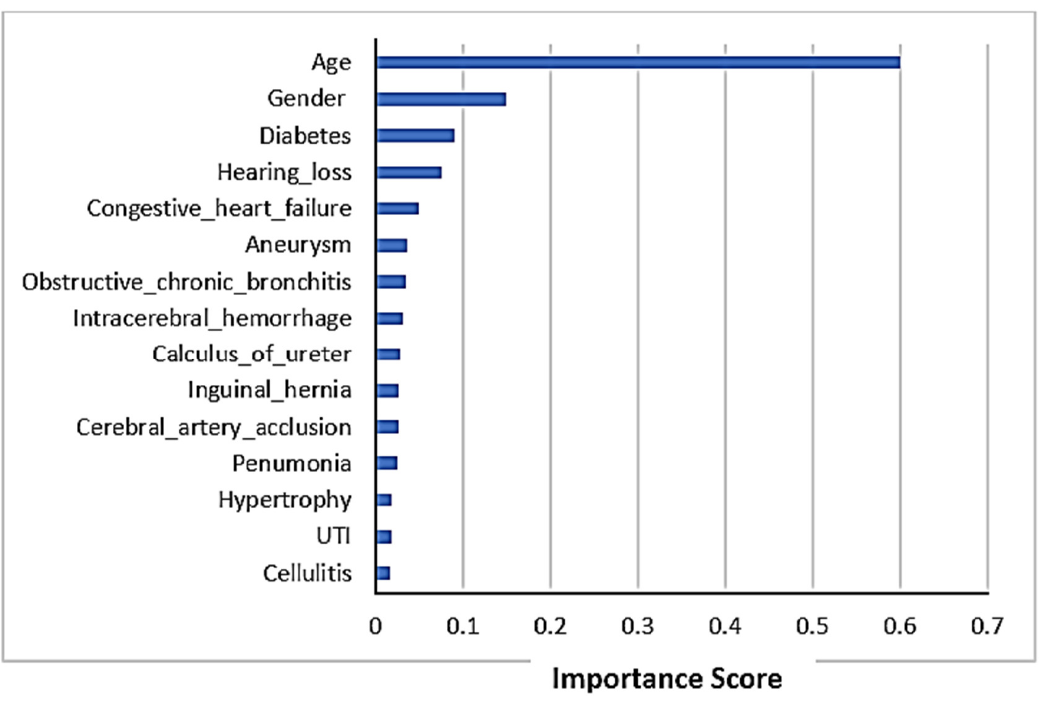
Table 4. Mortality prediction performance of various models for classification model.